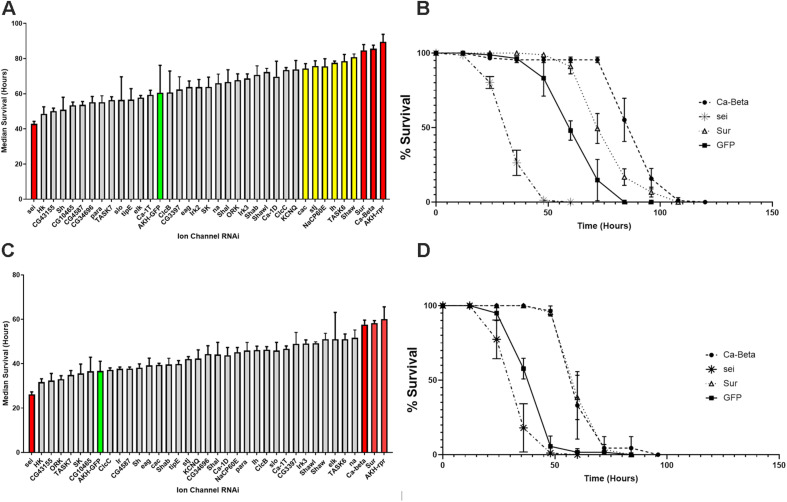
Starvation lifespan in strains with AKH-cell specific genetic knockdowns of different ion channel genes. The mean median survival was derived from three replicate vials of 30 individuals for each sex and was assessed during starvation conditions every 12 h. Mean median survival was determined for each genotype and is shown ± SEM. Bars in red denote significance levels at P < 0.01 and yellow bars denote significance levels at P < 0.05 from a One Way ANOVA and a Tukey post-hoc test comparing mean survival to the AKH-GFP controls (green). (A) Female starvation results are shown in the top panel and male starvation results are shown in the bottom panel (B). Starvation lifespan curves are plotted for the three strongest candidates (Sur, Ca-Beta, and sei) with control (AKH-GFP-RNAi) for females (C) and males (D).